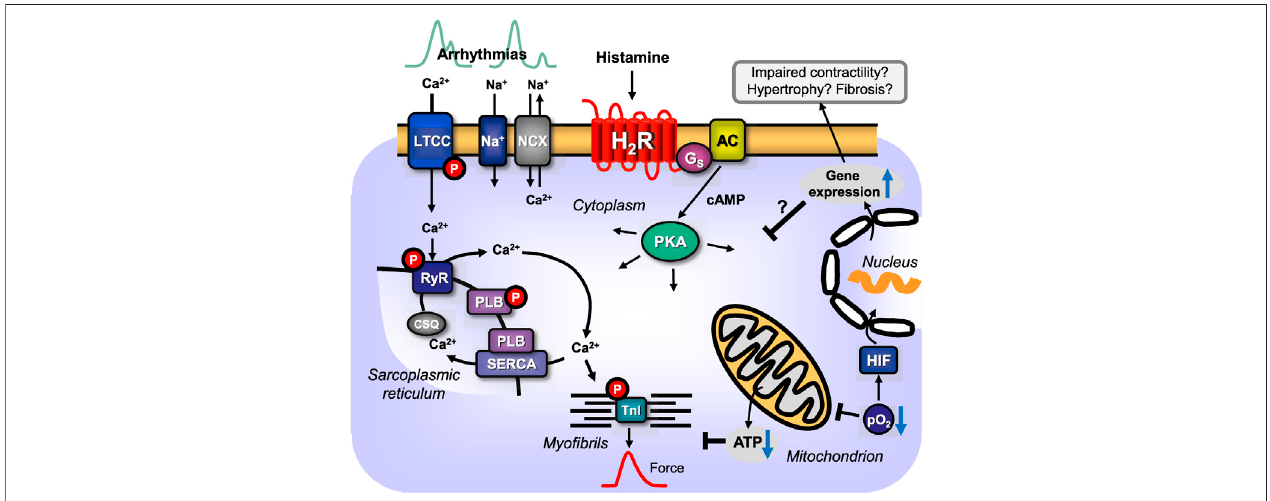
FIGURE 5 | Scheme: putative pathophysiological role(s) of cardiac H 2 -histamine-receptors (H 2 R). H 2 R via stimulatory GTP-binding proteins (Gs) can activate adenylyl cyclases (AC) which would enhance the 3 ′ ,5 ′ -cyclic adenosine-phosphate (cAMP)-levels in central compartments of the cardiomyocyte and activate cAMP- dependentproteinkinases(PKA),whichwouldincreasethephosphorylationstateandtherebytheactivityofvariousregulatoryproteinsinthecell(see Figure1A ).PKA- stimulatedphosphorylationmightalsoincreasethecurrentthroughtheL-typeCa 2+ channel(LTCC)and/orreleaseofCa 2+ fromthesarcoplasmicreticulum(SR)via the cardiac ryanodine receptor (RYR), which can occur in a non synchronous way that leads to early (top left) or delayed (top right) afterdepolarizations and thus to arrhythmias. In diastole, Ca 2+ is pumped via the SR-Ca 2+ -ATPase (SERCA) from the cytosol into the SR. Activity of SERCA is increased by phosphorylation of phospholamban (PLB). PKA can enhance nuclear gene transcription. In this context, the expression of putatively detrimental proteins may be enhanced and that may impair cardiac function by fostering fi brosis and hypertrophy, reduce cardiac contractility and may lead to heart failure. Hypoxia (reduced oxygen partial pressure: pO 2 ) and ischaemia impair respiration in the mitochondrion and thus formation of ATP in mitochondria or might activate directly hypoxia-inducible transcription factors (HIF). Increased expression or altered function of sarcolemmal ion channels like the sodium cation channel (Na + ) or the sodium/calcium exchanger (NCX) but also increased expression of H 2 -histamine receptors, can lead to supraventricular or ventricular arrhythmias by alteration of Ca 2+ homeostasis.